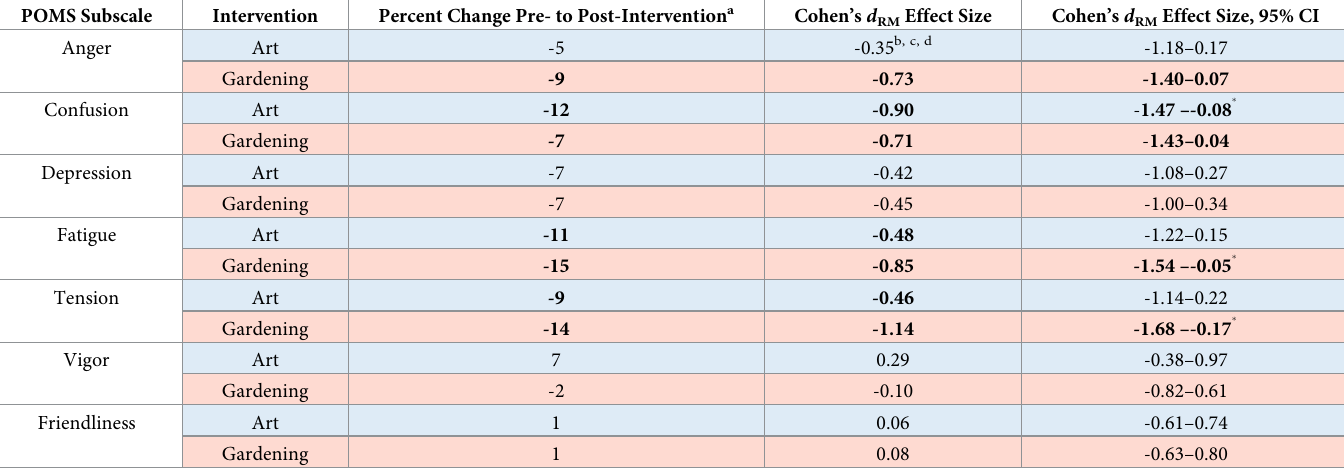
Table 9. Treatment effect size calculations for POMS subscales using Cohen’s d RM for repeated